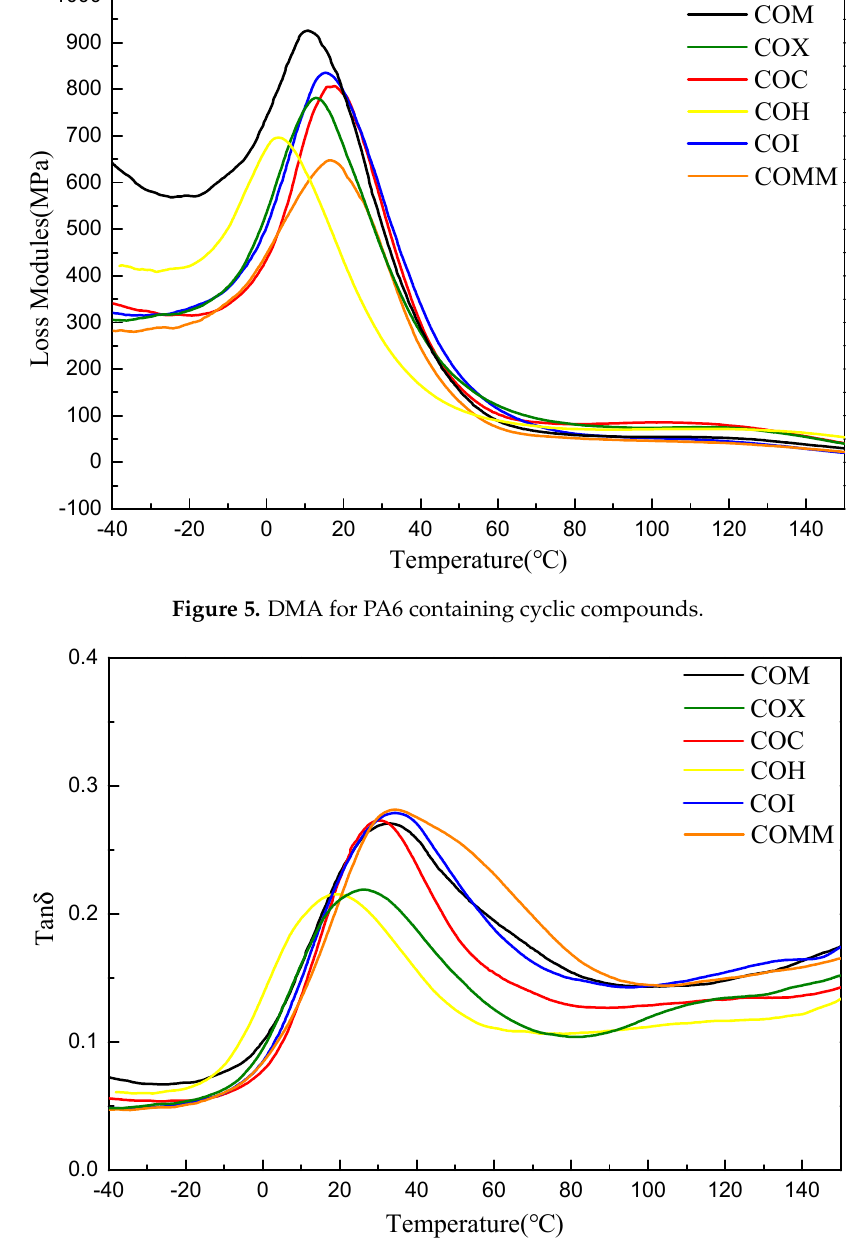
Figure 6. tan δ value for PA6 containing cyclic compounds.